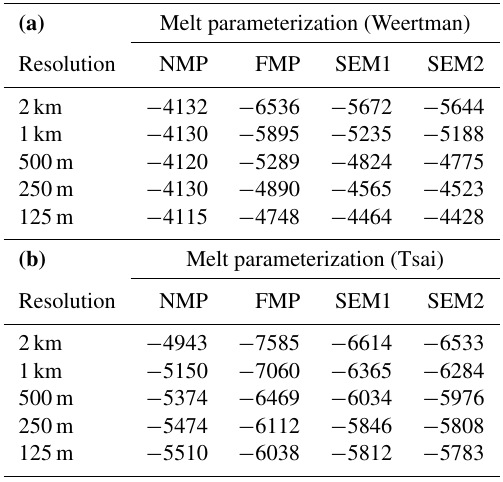
Table 2. Change in volume above floatation ( (cid:49) VAF inGt) in ex- periment 1 for the Weertman (a) and Tsai (b) friction laws.